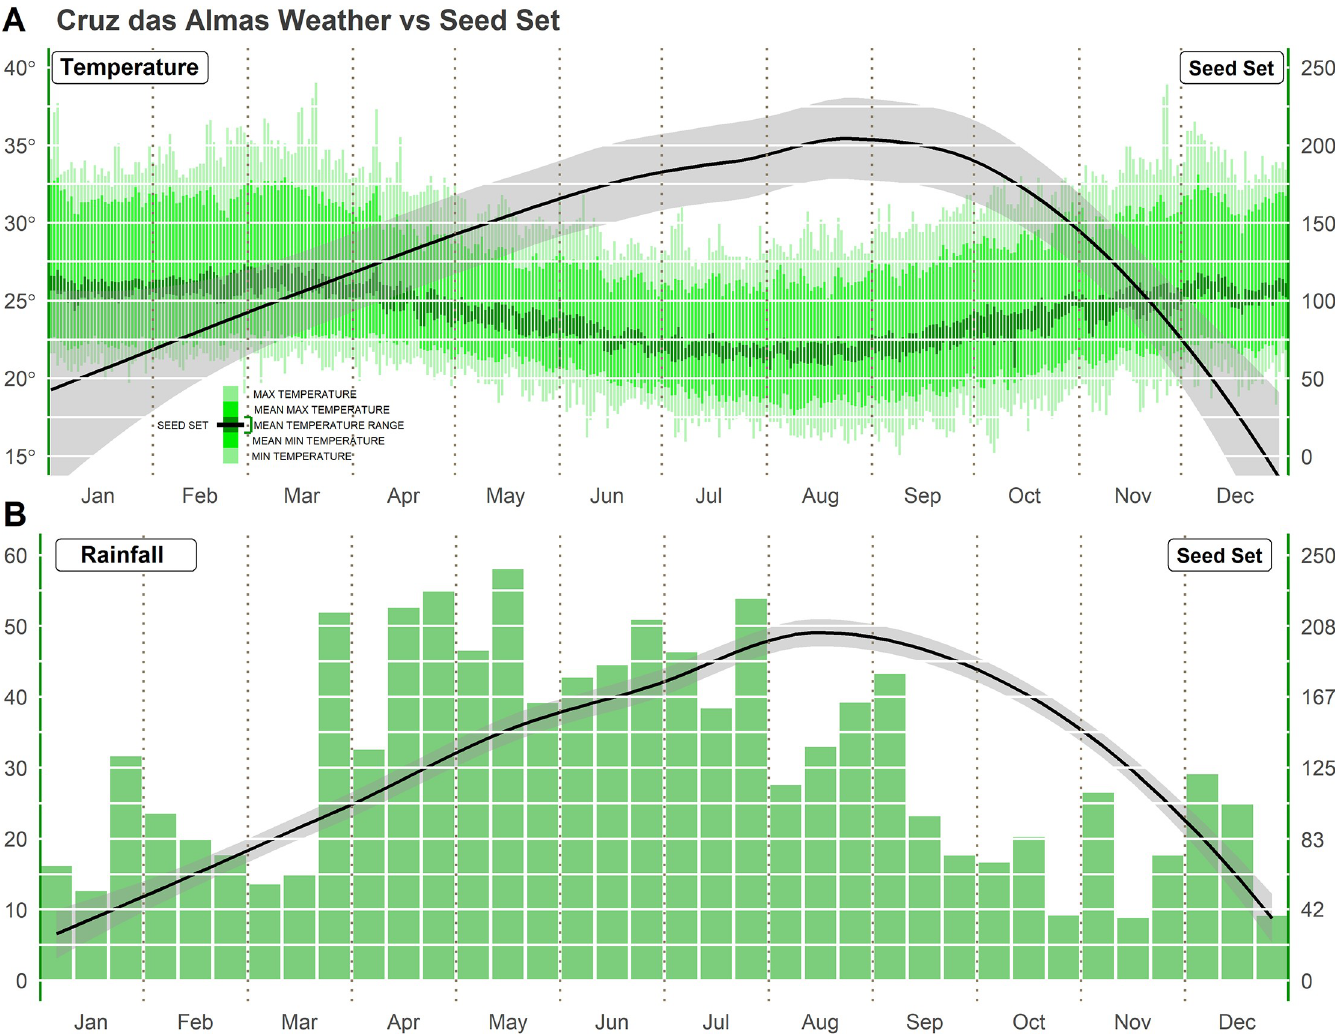
Fig 2. Average weather data for Cruz das Almas, Bahia, Brazil between 2010 and 2019 and the LOESS regression for average rainfall and temperature for seed setting. (A) Effect of average temperature on seed setting: light green–maximum and minimum daily temperatures; green–average maximum and minimum daily temperatures; dark green–confidence interval for average daily temperature. (B) Effect of accumulated rainfall per 10-day intervals (mm) on seed